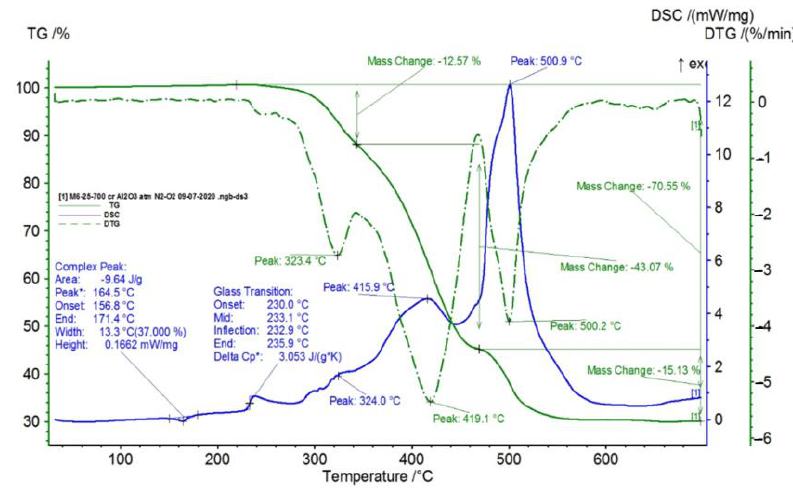
Figure 10. TG/DSC variation for sample M6.